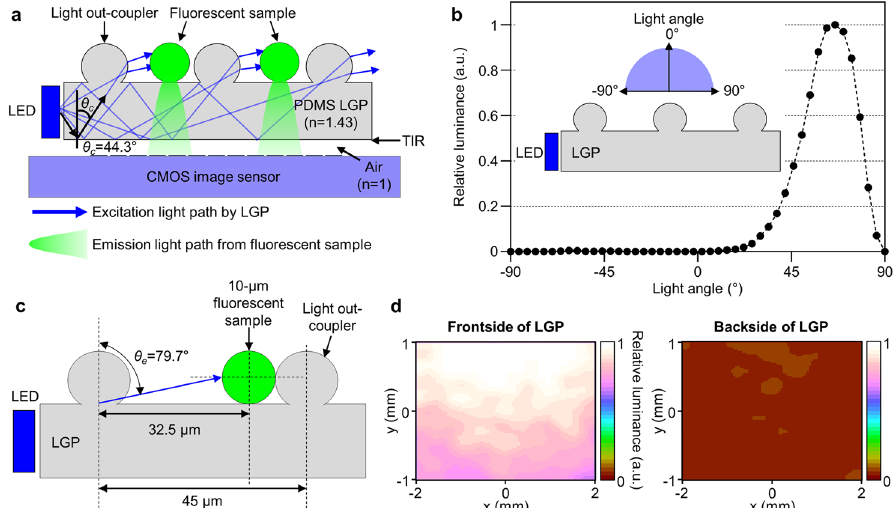
Fig. 2 Design and simulation results of the PDMS LGP. a Schematic diagram showing the overall con fi guration and operating principle of the fl uorescence imaging system integrated with a PDMS LGP. θ c is the critical angle. b Result of the simulation of the angular luminance distribution of PDMS LGP with spherical light out-couplers. c The maximum extracted angle of light ( θ e ) from the light out-coupler based on 10- μ m fl uorescent sample located on the top surface of the PDMS LGP, where the height of the light out-coupler is 10 μ m, the diameter of the light out-coupler is 15 μ m, and the pitch of the light out-couplers is 45 μ m. d Simulated spatial illumination distribution of (left) front and (right) back of the PDMS